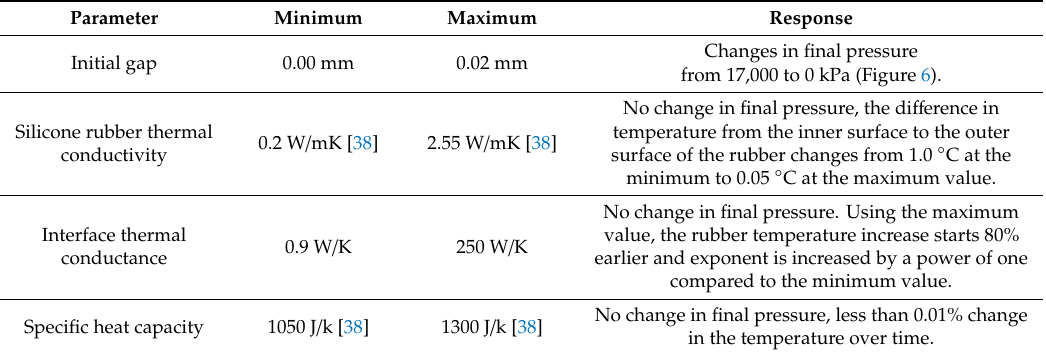
Table 3. Simulation sensitivity to unknown